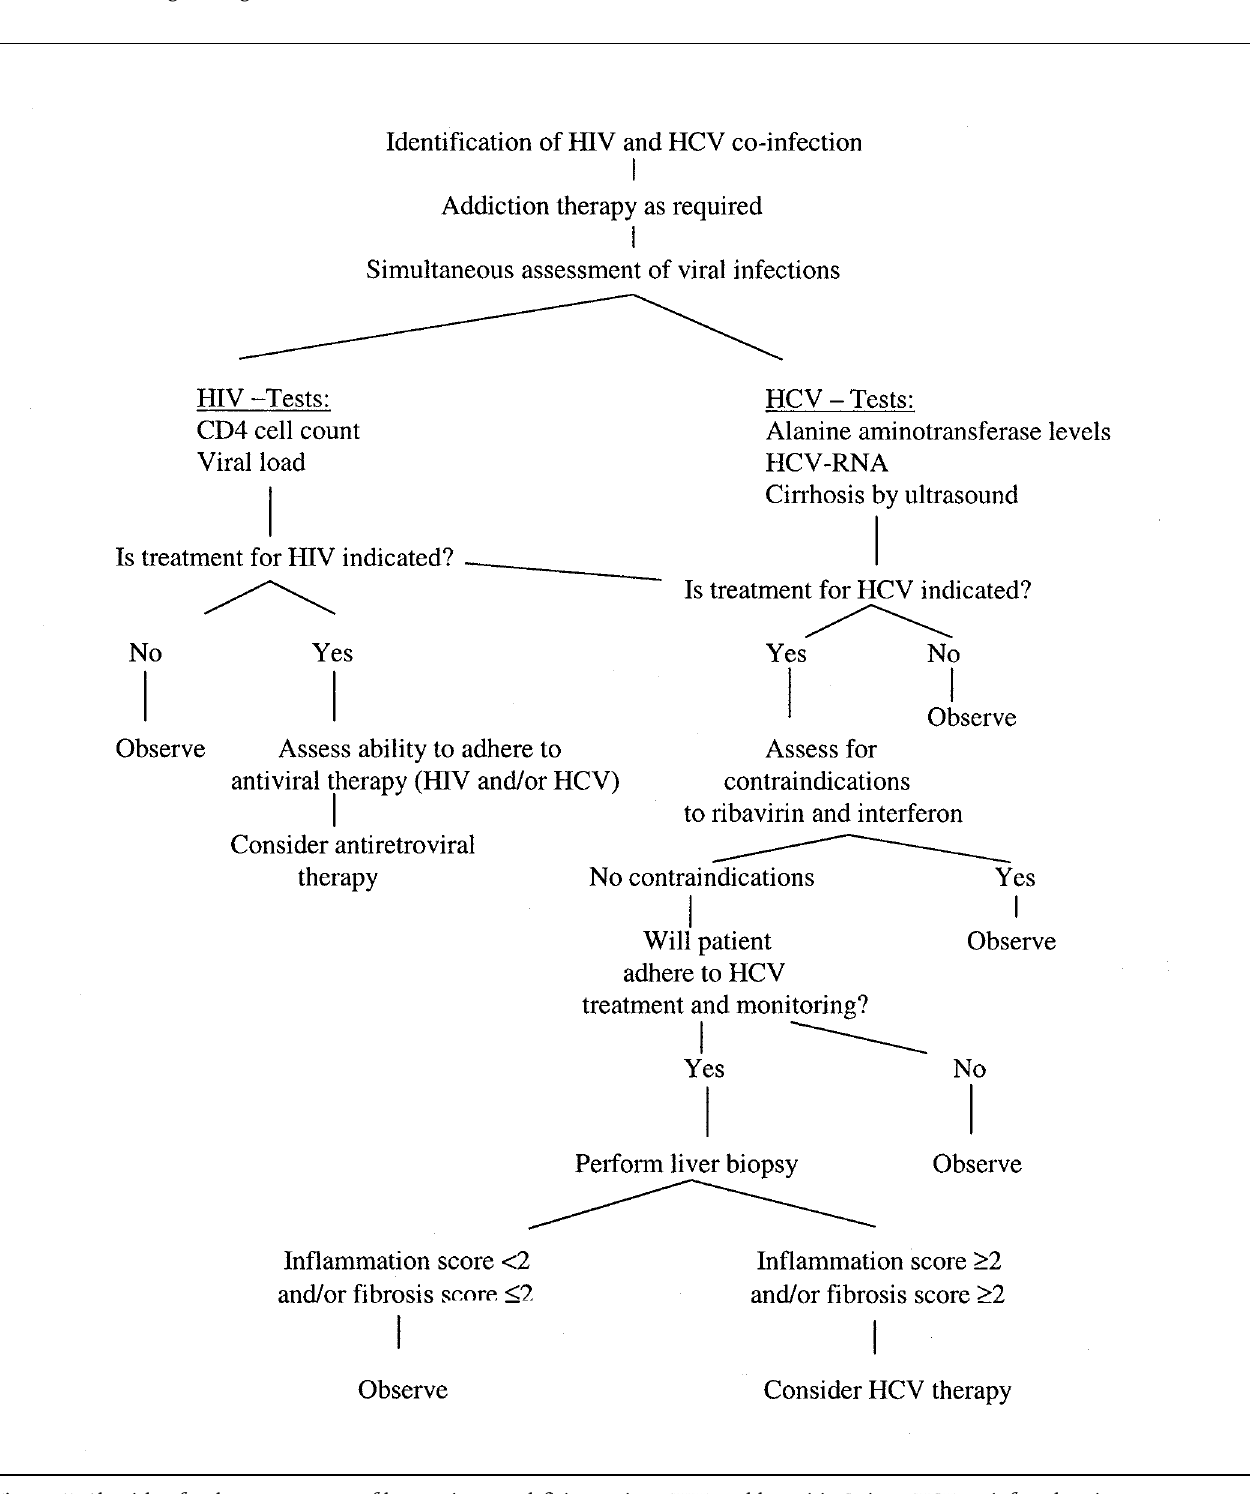
Figure 1) Algorithm for the management of human immunodeficiency virus (HIV) and hepatitis C virus (HCV) co-infected